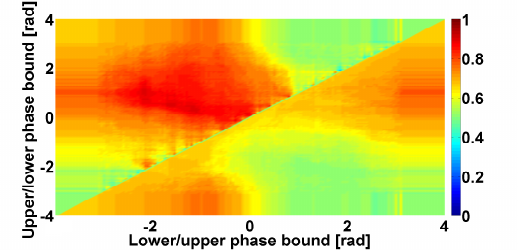
Figure 10. Example of Phase CWS AUC diagram. Tremor signals in antagonist muscles of left arm with hyperkinetic movements in PD and ET patients are analyzed. Cross-wave trains in the frequency range from 8 to 18 Hz are considered. The axes are the same as in Figure 8.